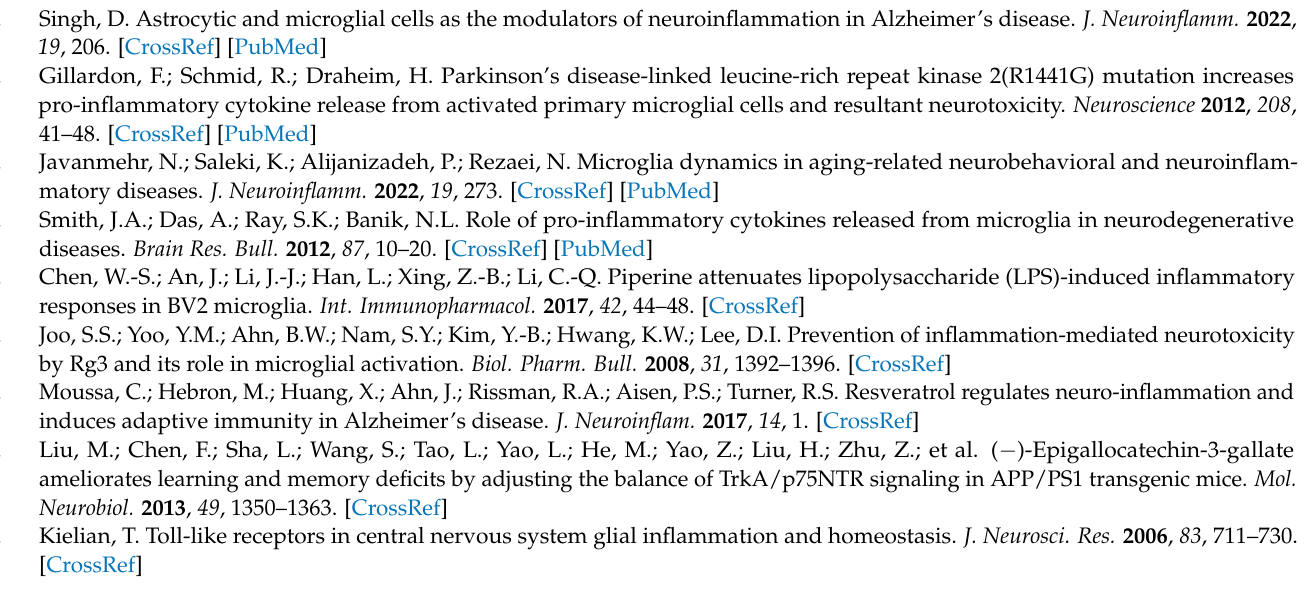
The 13 C-NMR spectrum of compound 5 (Ergosterol). Figure S4. The structure of compound 5 (Ergosterol). Figure S5. The HRESIMS spectrum of compound 5 (Ergosterol). Figure S6. The structure of compound 24 (corymbocoumarin). Figure S7. The 1 H-NMR spectrum of compound 24 . Figure S8. The 13 C-NMR spectrum of compound 24 . Figure S9. The HRESIMS spectrum of compound 24 . Figure S10. The structure of compound 48 (Ua1). Figure S11. The 1 H-NMR spectrum of compound 48 . Figure S12. The 13 C-NMR spectrum of compound 48 . Figure S13. The HRESIMS spectrum of compound 48 . Figure S14. The structure of compound 49 . Figure S15. The 1 H-NMR spectrum of compound 49 . Figure S16. The 13 C-NMR spectrum of compound 49. Figure S17. The HRESIMS spectrum of compound 49